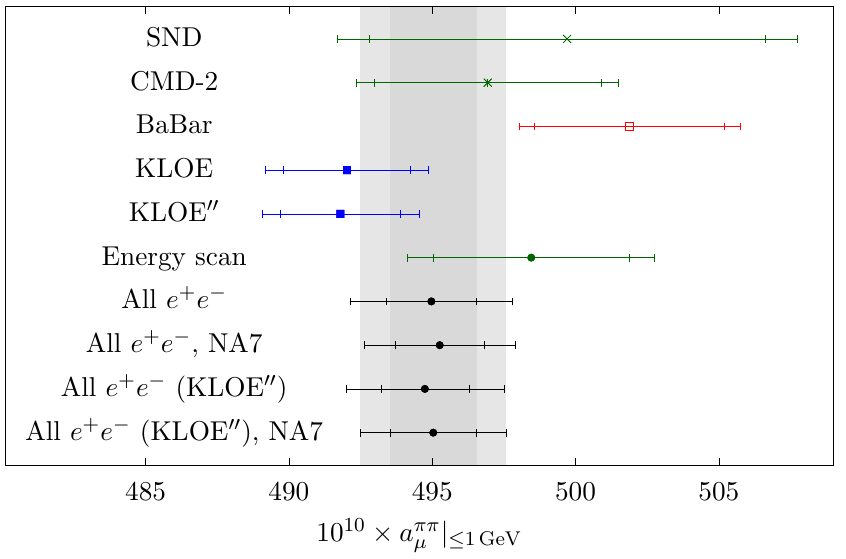
Figure 14. Results for a (cid:25)(cid:25) in the energy range (cid:20) 1 GeV. The smaller error bars are the (cid:12)t (cid:22) p uncertainties, in(cid:13)ated by (cid:31) 2 = dof, the larger error bars are the total uncertainties. The gray bands indicate our (cid:12)nal